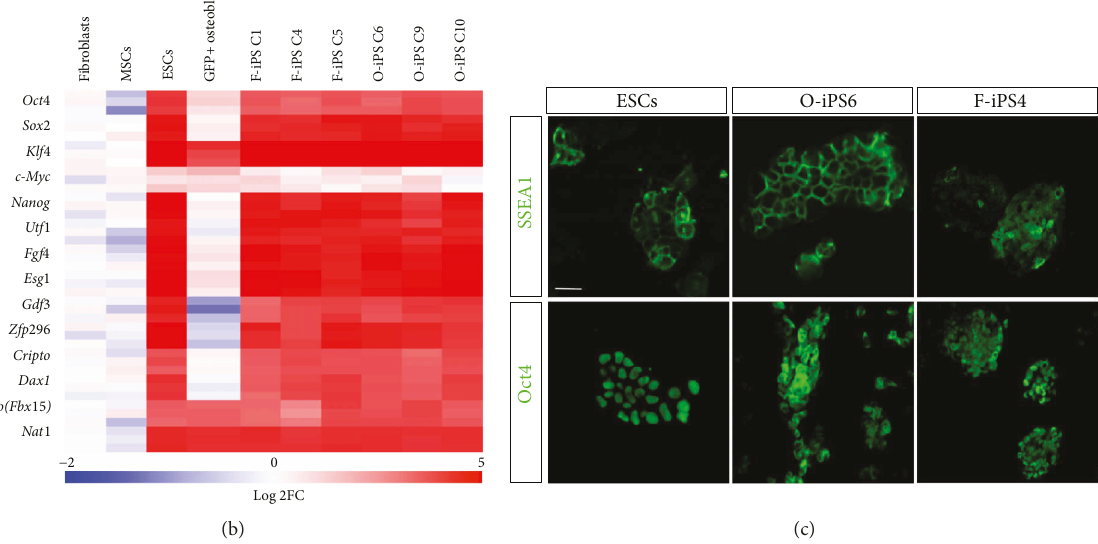
Figure 3: Gene expression pro fi les of O-iPS cells. (a) qPCR analysis for the indicted transcript levels in 3 F-iPS clones, 3 O-iPS clones, sorted GFP + osteoblasts, ESCs, and MSCs. Individual mRNA expression levels were normalized to Gapdh with fold change relative to dermal fi broblasts which is arbitrary set to 1. (b) Heatmap of log fold change (Log2 FC) values for expression levels of the indicated transcripts in fi broblasts, MSCs, ESCs, GFP + osteoblasts, F-iPS, and O-iPS clones. (c) Immuno fl uorescence of ESCs, O-iPS clone 6, and F-iPS clone 4 for antibodies against SSEA1 and OCT4. Scale bar: 100 μ m. Three independent experiments are represented in (a). Data are expressed as means ± SEM. ∗∗ p < 0 01 ; ∗∗∗ p < 0 001